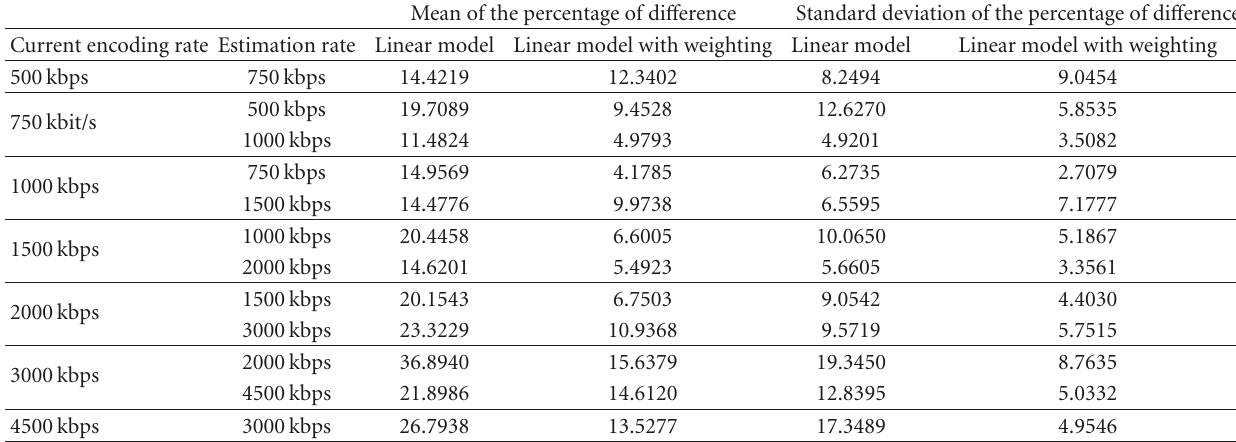
Table 3: Mean and standard deviation (calculated over the GOPs) of the estimation error (in percent) between the actual and the estimated MSE, table